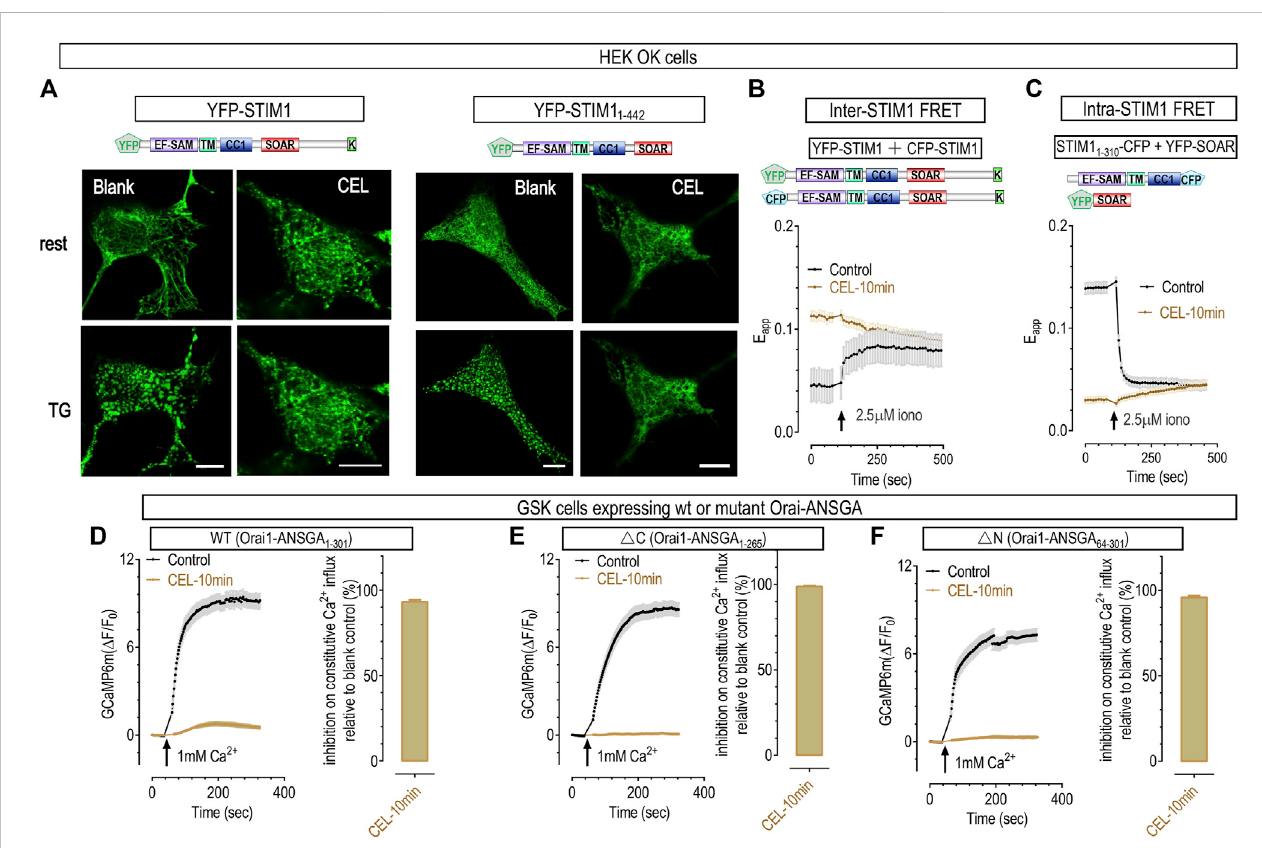
FIGURE 5 50 μ M celastrol inhibited the formation of STIM1 puncta and Ca2+ in fl uxes through constitutively active Orai1 mutants. (A) Representative confocal images showing theeffects of celastrol on the store-dependent distribution of YFP-STIM1 or YFP-STIM1 1-442 transiently expressed in HEK OK cells. Protocols used to induce storedepletion by TG werethe same as those in Figure 4A. For full-length STIM1 (Lefttwo panels), unlike those inblank control cells (left most panels), celastrol-treatments induced minimal STIM1 punctate at rest and blocked the formation of store-dependent STIM1 puncta (right). As to YFP- STIM1 1-442 (right two panels), they behave similarly to full length STIM1 in control cells (left), while celastrol completely blocked the formation of STIM1 1-442 puncta (right). (B) Celastrol ’ s effects on FRET signals between YFP-STIM1 and CFP-STIM1 transiently co-expressed in HEK SK cells. Compared to control, pretreatmentwith celastrol resulted inahigher basal STIM1-STIM1 FRET signal, and abolished ionomycin-induced increases in thisFRET signal. (C) Celastrol ’ s effects on FRET signals between STIM1 1-310 -CFP and YFP-SOAR transiently co-expressed in HEK SK cells. Compared to control, pretreatment with celastrol resulted in a signi fi cantly lower basal STIM1 1-310 - SOAR FRET signals, and abolished ionomycin-induced increases seen in control cells. (D – F) Celastrol ’ s effects on Ca 2+ in fl uxes mediated by constitutively active Orai1 mutants in GSK cells transiently expressing Orai1-ANSGA (D) , Orai1-ANSGA- Δ C (1-265) (E) or Orai1-ANSGA- Δ N (64-301) (F) . The constitutive Ca 2+ in fl ux were greatly inhibited by celastrol. Left, Typical traces; right, Statistics. At least three independent repeats were carried out for each